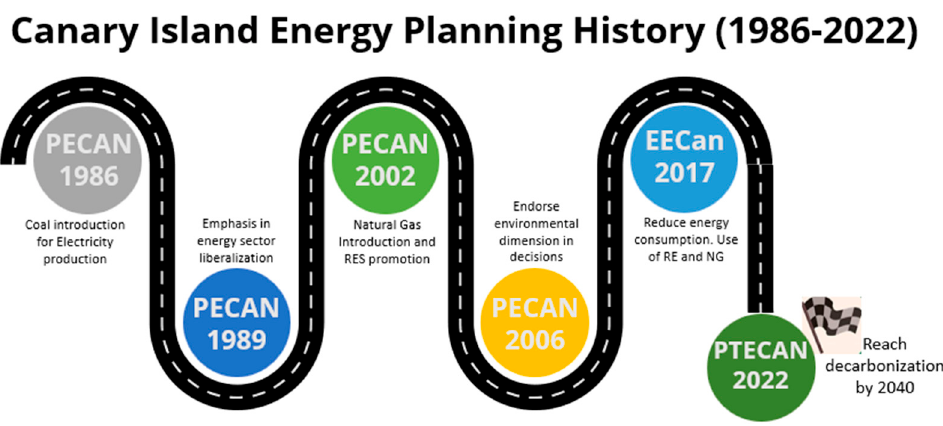
Figure 2. Canary Islands Energy Planning History. Own elaboration.